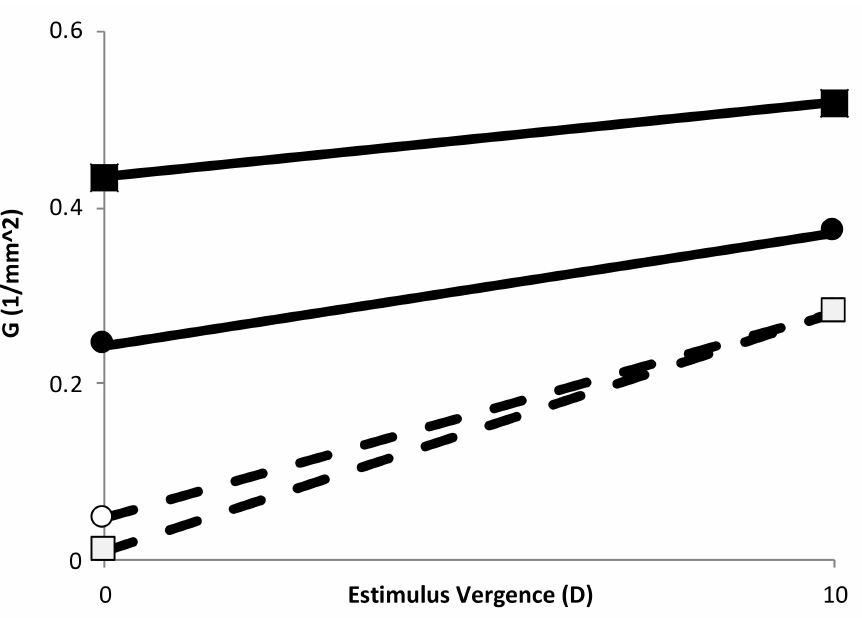
Figure 3. Gradient of curvature of the anterior half (circles) and posterior (squares) part of the lens for Gullstrand’s eye model (empty symbols) and the DB eye model (filled symbols). Lines are drawn to show the tendency after